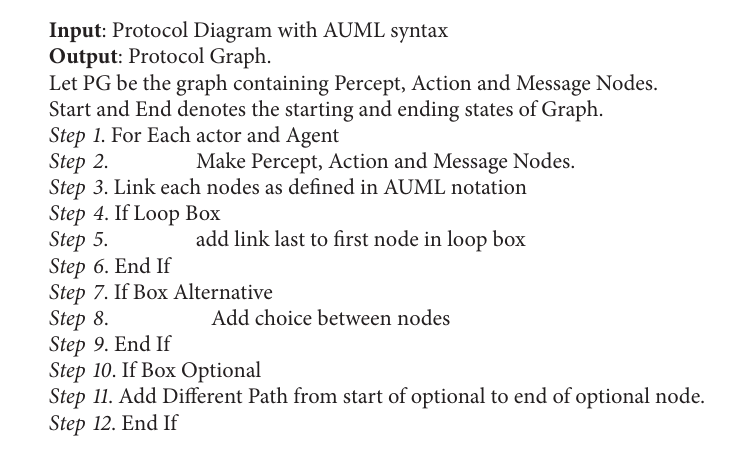
Algorithm 1: Converting protocol diagram into protocol graph.